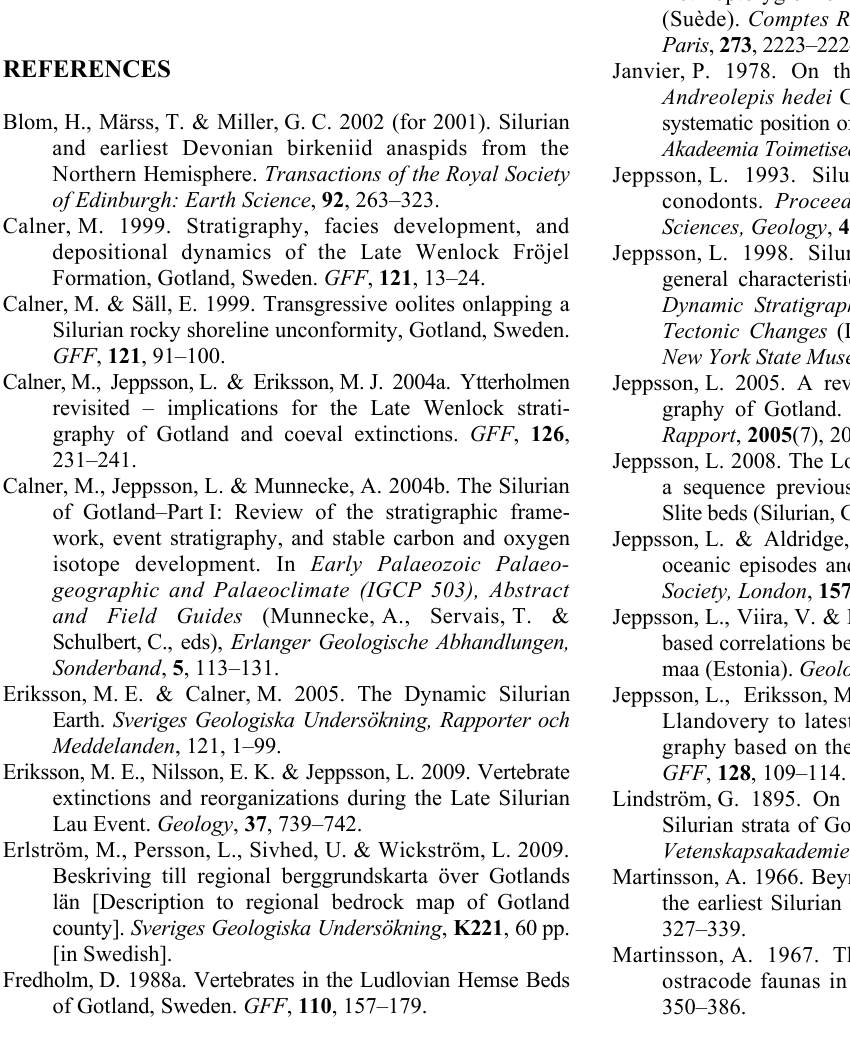
Fig. 2. Vertebrate group occurrence and diversity through the Silurian of Gotland. Most taxa are represented by different colours and Andreolepis hedei is represented by the letter A (see key in Fig. 2). The thickness of the taxon symbol determines how many taxa of a particular group are present in the four different facies. The (cid:145)Total diversity(cid:146) column shows the total, definite diversity of all vertebrate groups in Gotland through time, disregarding facies. The colours of the stratigraphic units correspond to those on the geological map of Gotland from Fig. 1. Thick horizontal and vertical lines in the column (cid:145)Gotland stratigraphy(cid:146) mark unconformities. Numbers to the right in the columns show the total number of samples that were targeted for vertebrates. The thickness of the stratigraphical units does not reflect the true thickness of the formations, i.e. they are not in scale. Stratigraphy is based on Jeppsson et al. (2006), formations with lowercase letters have not been formally